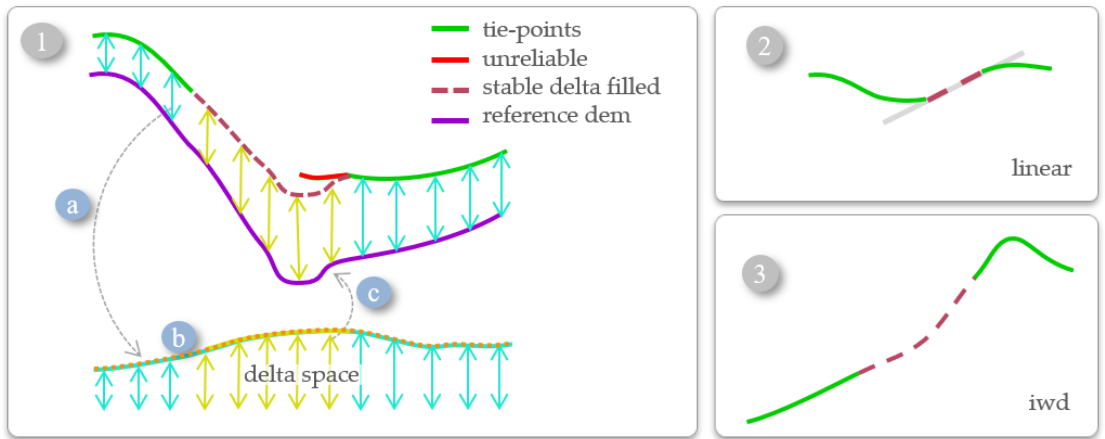
Figure 6. Gap filling approaches: ( 1 ) interpolation where external reference DEM is available using a co-registered external reference DEM (purple) trough the following steps: (a) valid delta map (turquoise), (b) gap interpolation on the delta space (yellow), and its low-pass (orange) (c) is finally added to the reference to get the filled value (bordeaux). DEM reliable pixels are depicted in green. ( 2 ) and ( 3 ) are interpolation without an external reference ( 2 ) small isolated gaps: linear, ( 3 ) others: inverse distance weighted